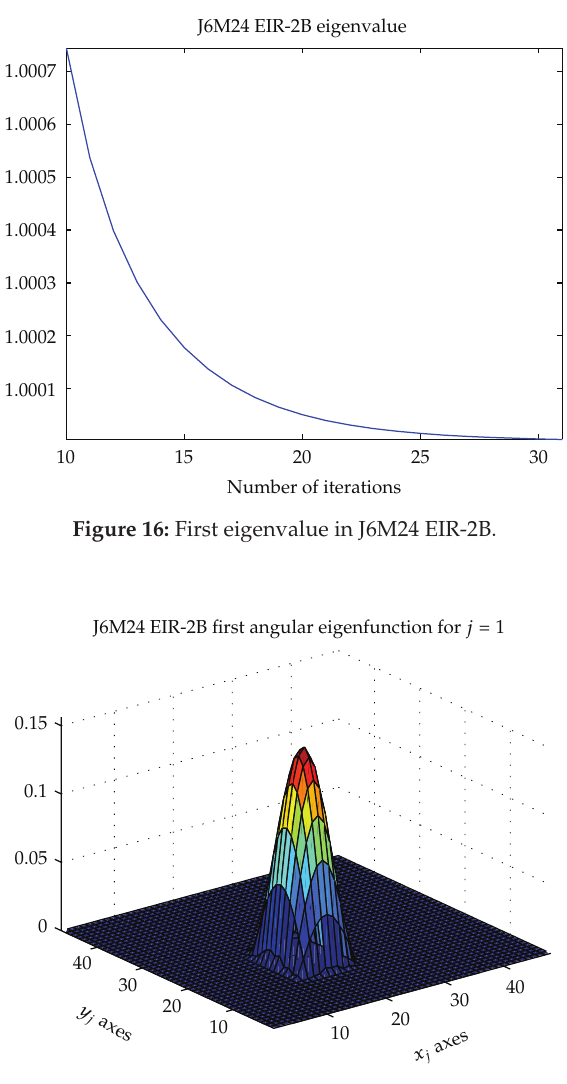
Figure 17: First eigenfunction in J6M24